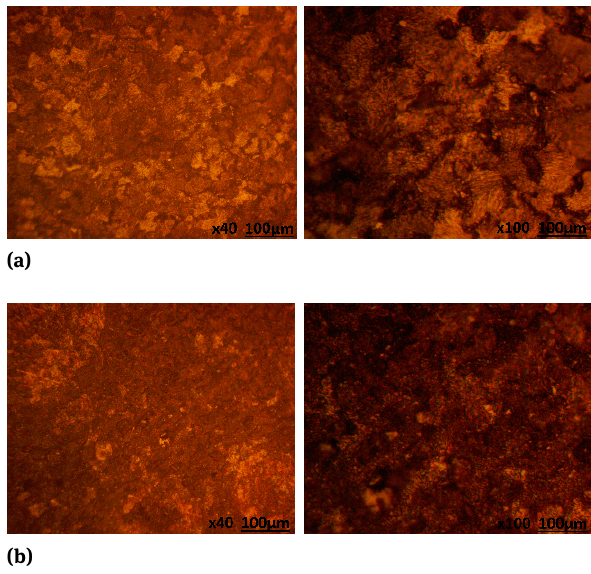
Figure 4: Optical images of LCS surface after polarization from (a) H 2 SO 4 solution and (b) HCl solution at 5% TMAV concentration